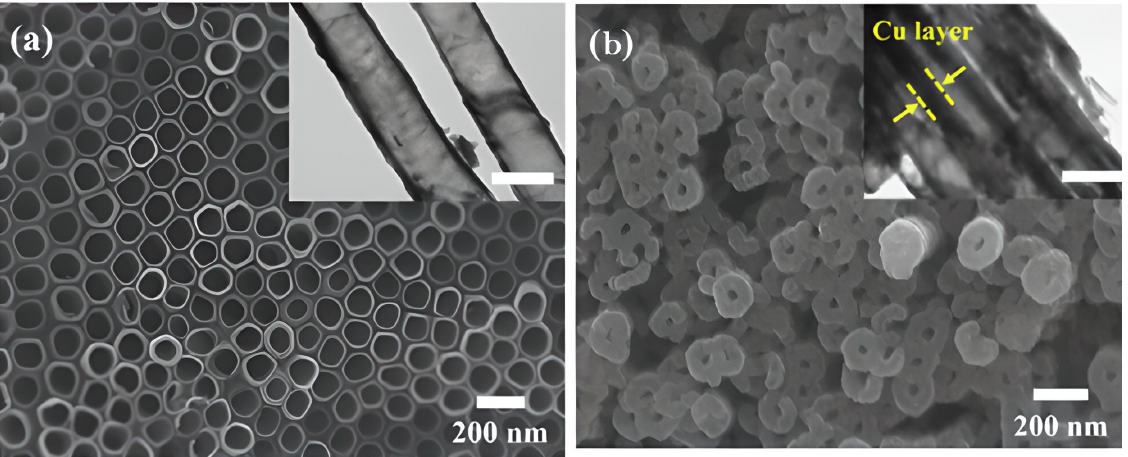
Figure 10. SEM and TEM (inserts) images of parent TiO 2 NT. According to the SEM and TEM images, the TiO 2 NT array shown in ( a ) is uniformly distributed on the surface, with the lengths of the TiO 2 NTs. ( b ) Cu is uniformly deposited on the surface of the TiO 2 NTs. Reprinted with permission from Ref. [66] . Copyright © 2015 Elsevier